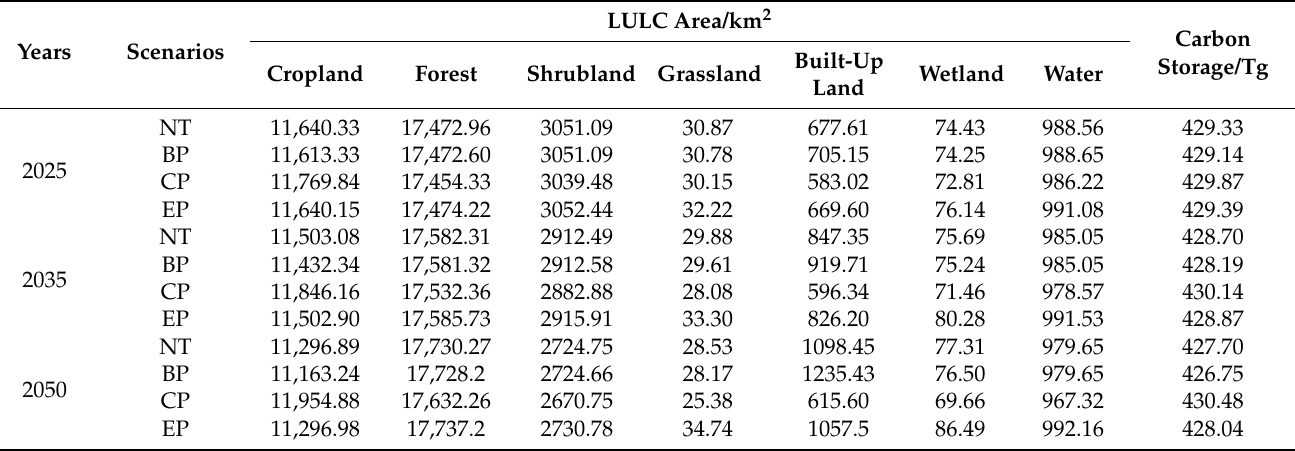
Figure 10. ( a ) The actual LULC distribution in 2019 and ( b ) the simulated LULC distribution in 2019. Table 7. Future LULC and carbon storage under four different